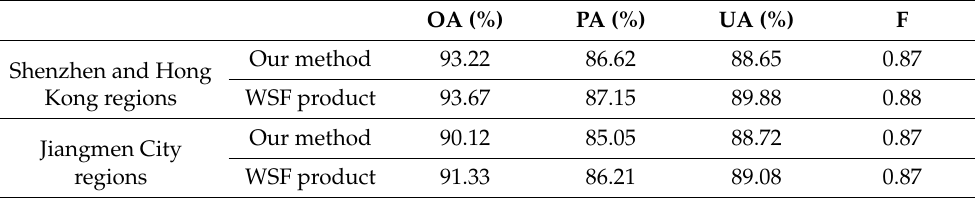
Table 5. Bas extraction accuracy comparison of the proposed method and the WSF